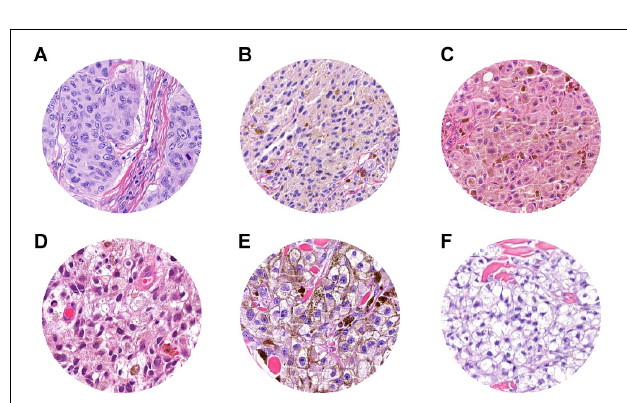
FIGURE 6 | ROI samples in which false-negative patches were identified. (A) Absent pigmentation. (B–D) Mild pigmentation. (E) Prominent pigmentation. (F) Clear cell changes in melanoma